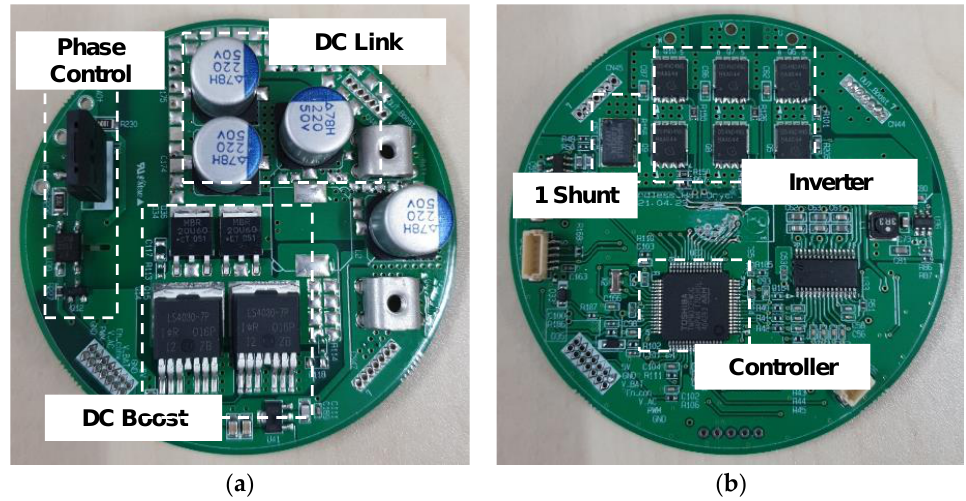
11 of 16 Figure 9. Controller block diagram of 1-shunt sensorless 3-phase inverter. 5. Experimental Results Figure 10a,b show the HW PCB, which is composed of two layers. Phase control, dc boost, and dc link are configured on the front part of the first floor of HW, and the lower